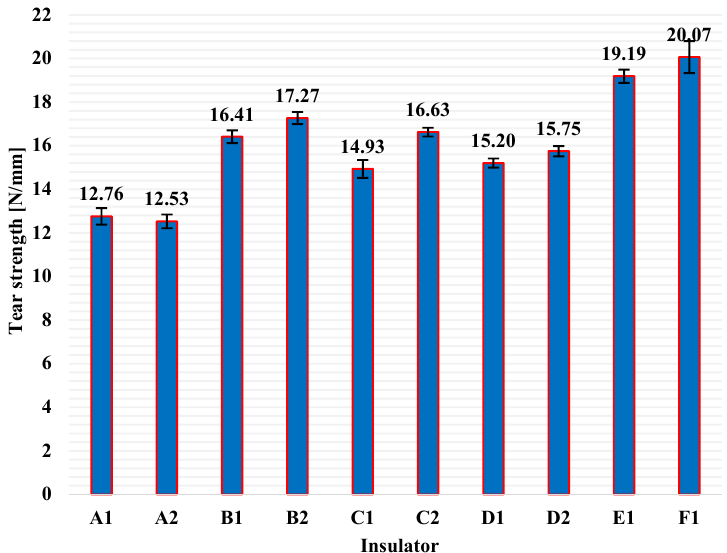
Figure 10. Tear strength average values (columns) and the corresponding standard deviations (error bars) for the HTV silicone rubber with ATH filler material of all available composite